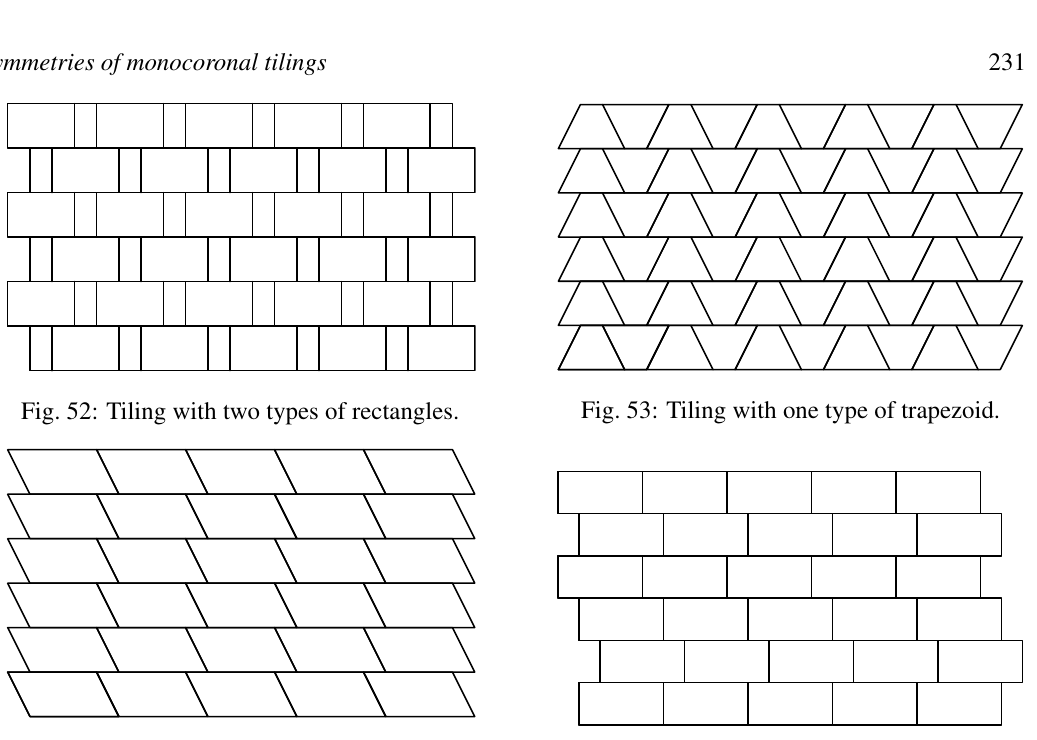
Fig. 54: Tiling with one type of parallelogram (D). And there are two additional tilings for the second case.